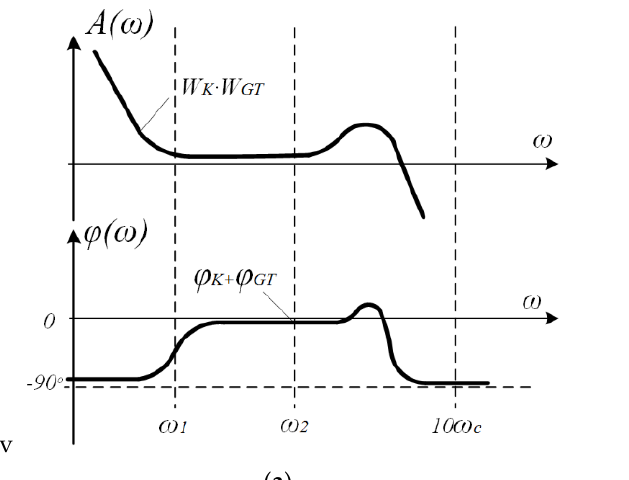
Figure 10. Model of a variable structure system with delay links.